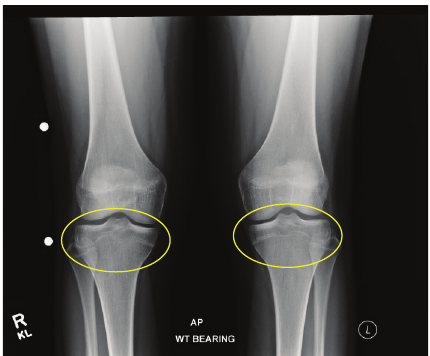
Figure 7: A 14-year-2-month-old female with FOPE zone of the proximal tibia. Findings: AP radiograph of both knees shows bilateral symmetric partial closure of the central portion of the proximal tibial physis (ovals). Technique: AP radiograph kVp = 70, mAs =